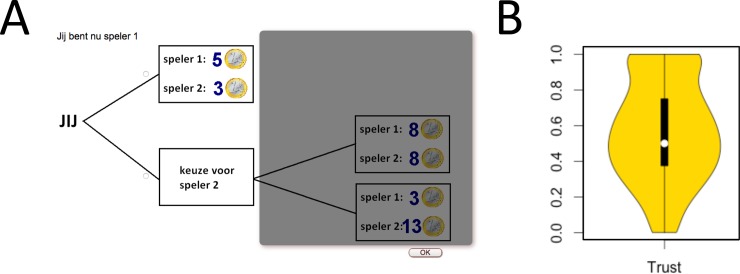
The Trust game.(A) When the participant was the first player he or she could decide to either trust or not trust the other person. The possible outcomes for trusting where shaded to indicate the role of the participant but still clearly visible to understand the possible consequences. (B) Distributions of percentages of trust choices, white circle is the population mean.